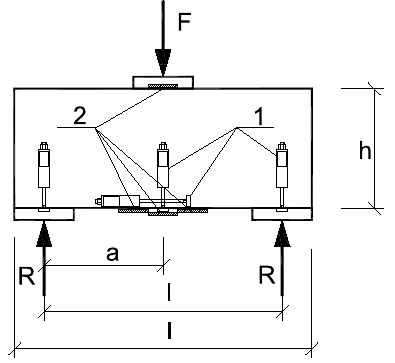
Fig 2. Loading configuration and location of gauges, where 1 is deflection gauges, and 2 is strain